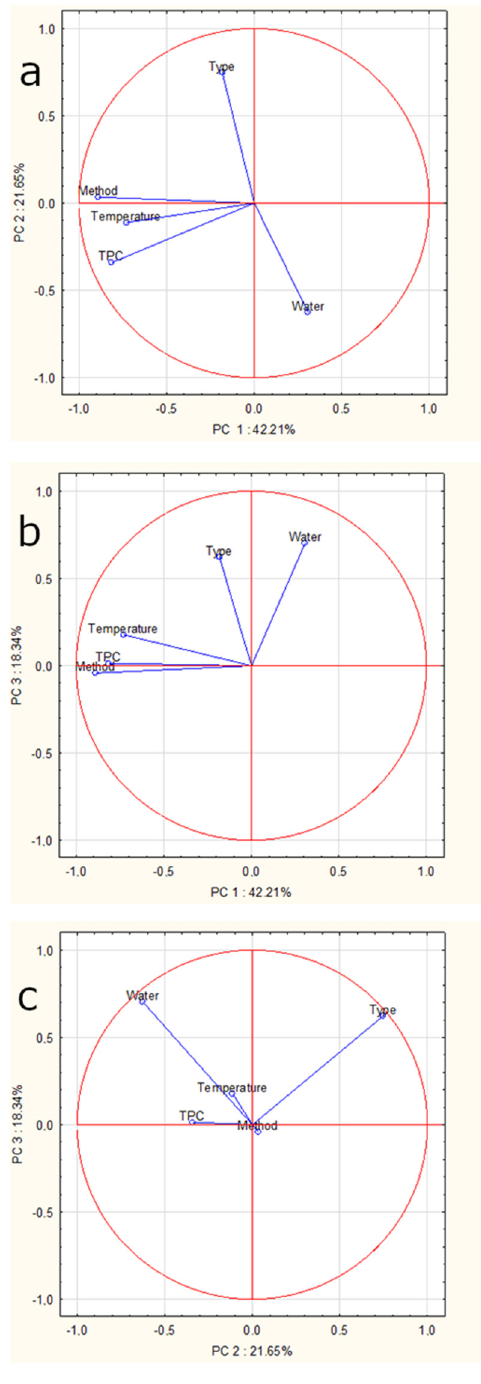
Figure 9. Plot of the principal component for the variables: ( a ) Principal Component 1 and 2, ( b ) Principal Component 1 and 3, ( c ) Principal Components 2 and 3.